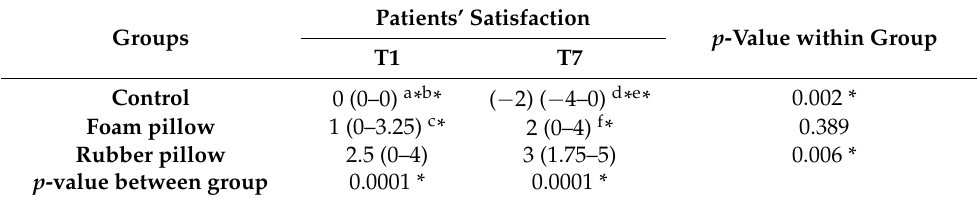
Table 3. The comparison of patients’ satisfaction within and between groups.